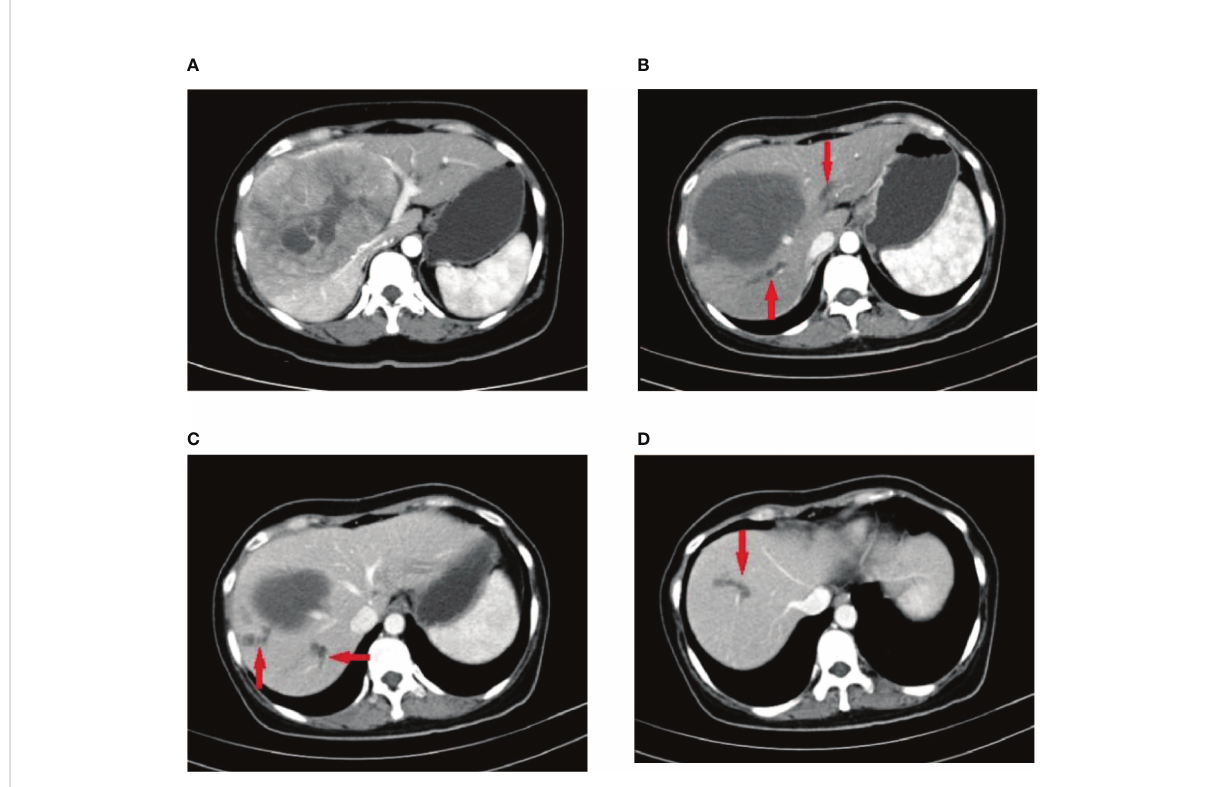
Table 2, a history of hepatectomy (odds ratio [OR], 2.285;